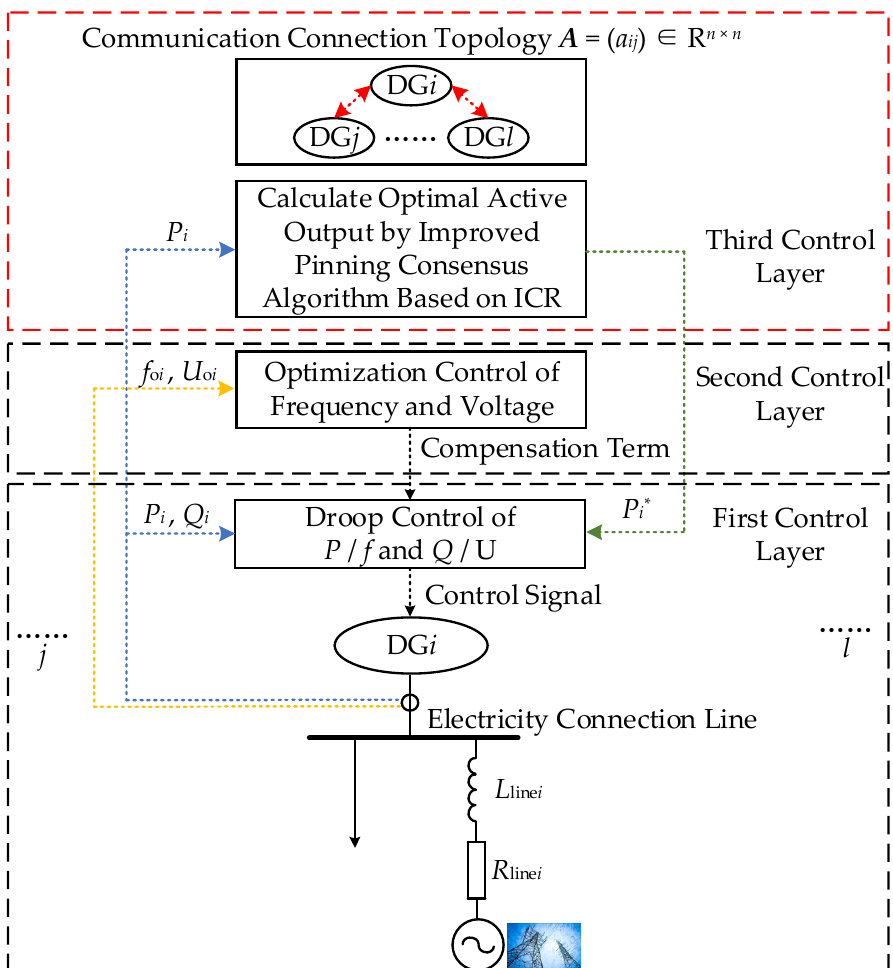
Figure 2. Distributed hierarchical control architecture of grid-connected microgrids.